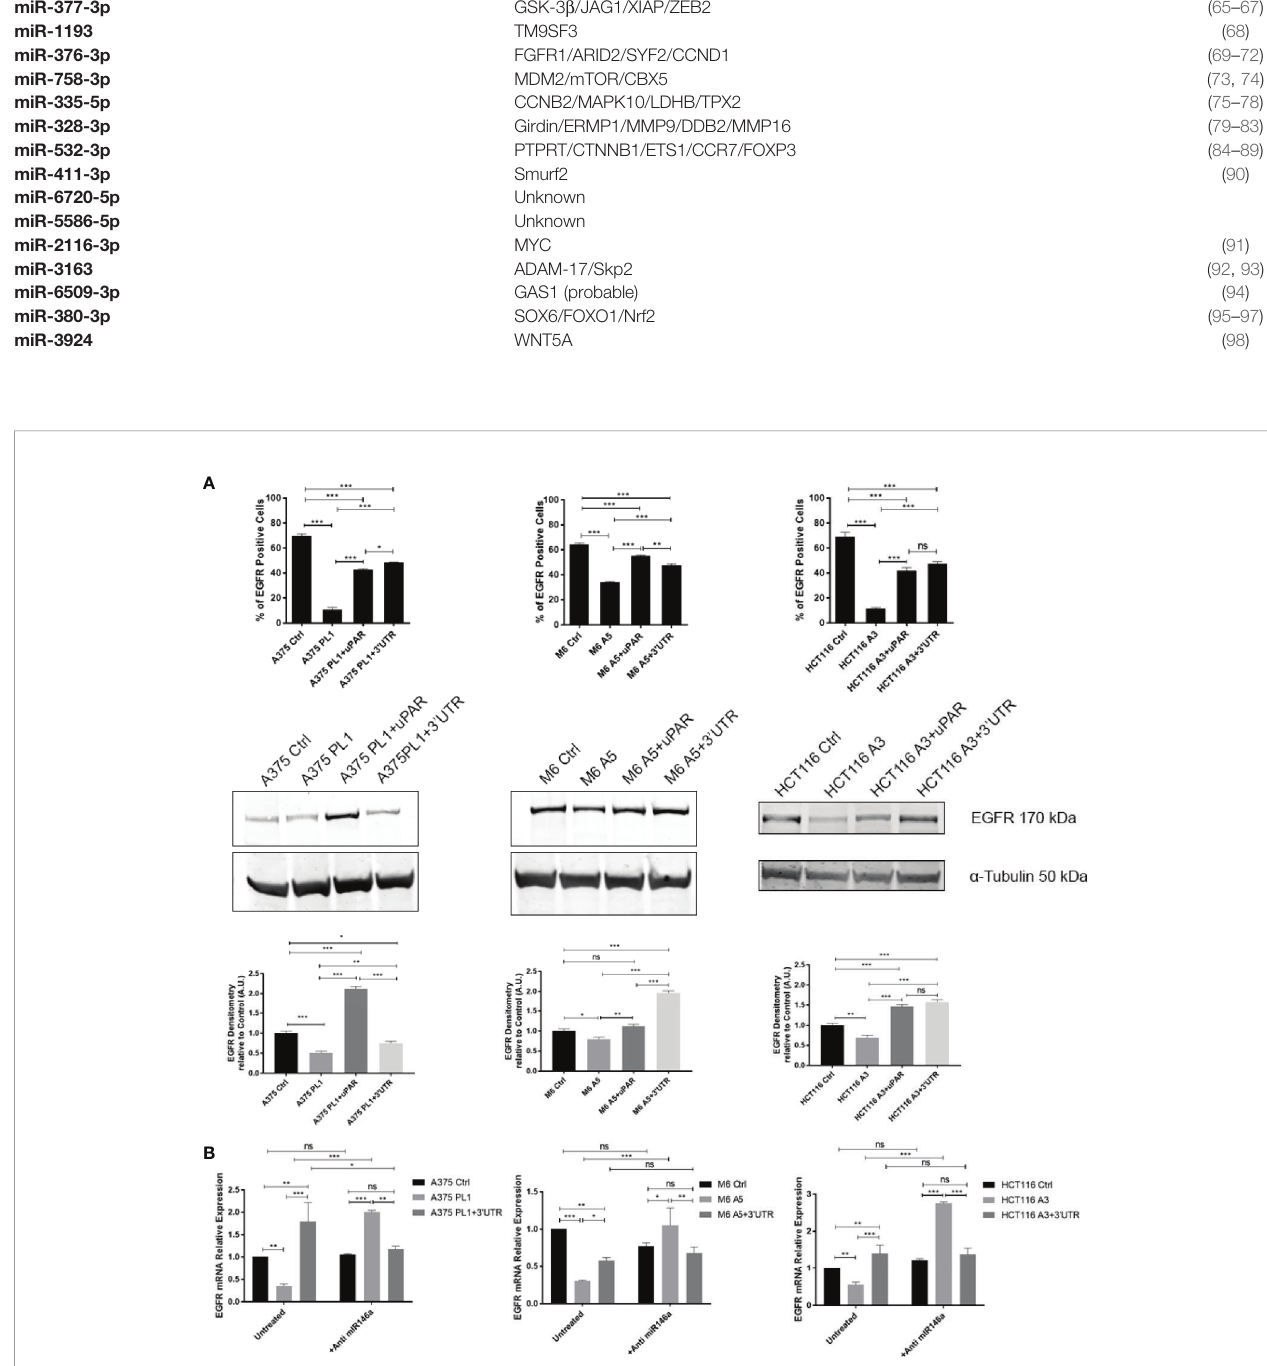
FIGURE 5 | (A) Cells were tested for EGFR expression by FACS analysis and Western Blotting (n = 3). (B) Total RNA isolated using Tri Reagent was subjected to RT – PCR and qPCR, evaluating EGFR expression after anti-miR146a treatment for 24 h (n = 3). Values are mean ± SD; *p <0.01, **p <0.001, ***p <0.0001, ns, not signi fi cant (One-Way ANOVA).